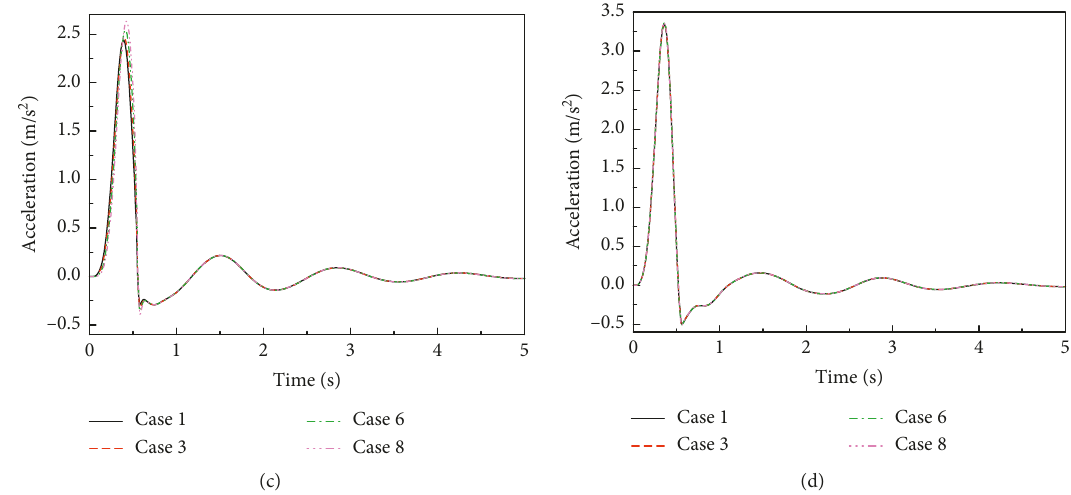
Figure 6: Acceleration time history curves of measuring points in model tests (single damage). (a) Point 1. (b) Point 7. (c) Point 12. (d) Point 25.